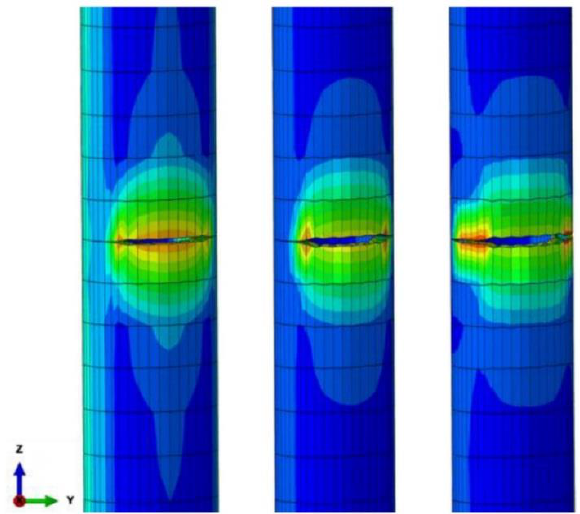
ff erent injection times.